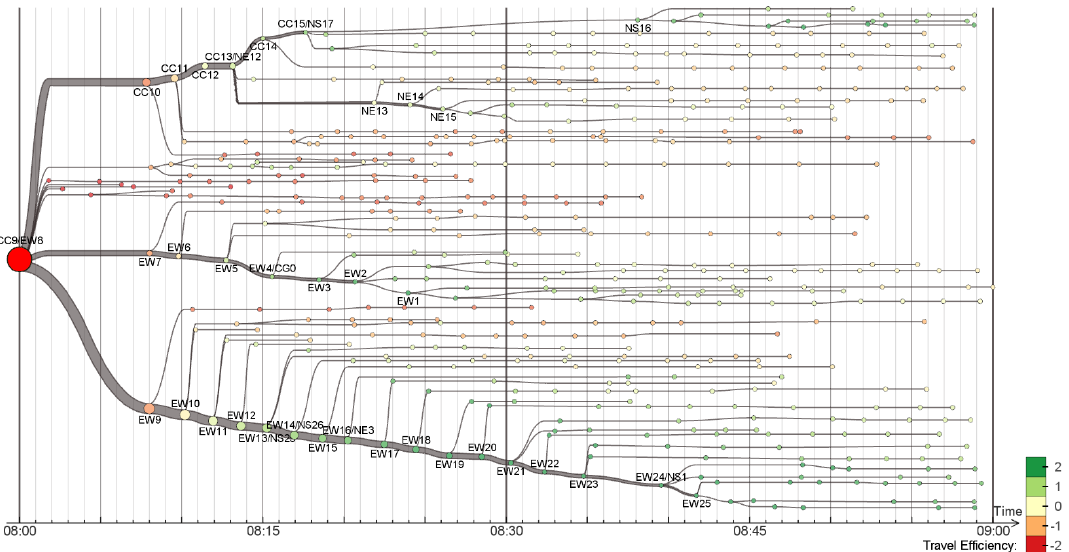
Figure 14. The isotime visualization technique for exploration of time efficiency of journeys based on a starting stop [61] (extracted from [63]).